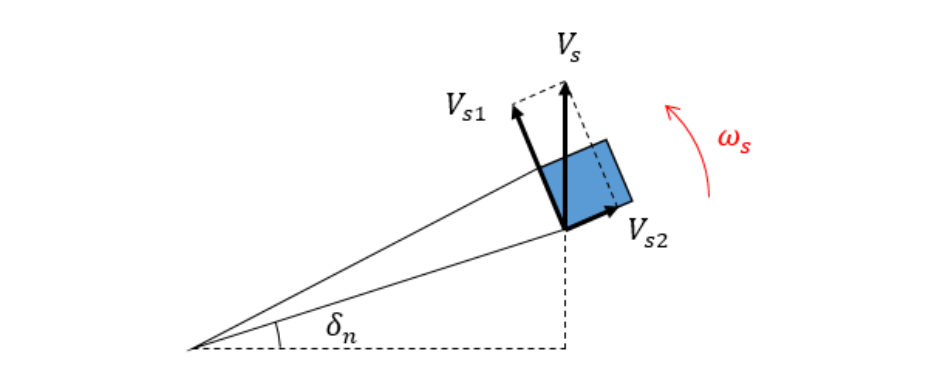
Figure 16. The ground coverage image at time t n .